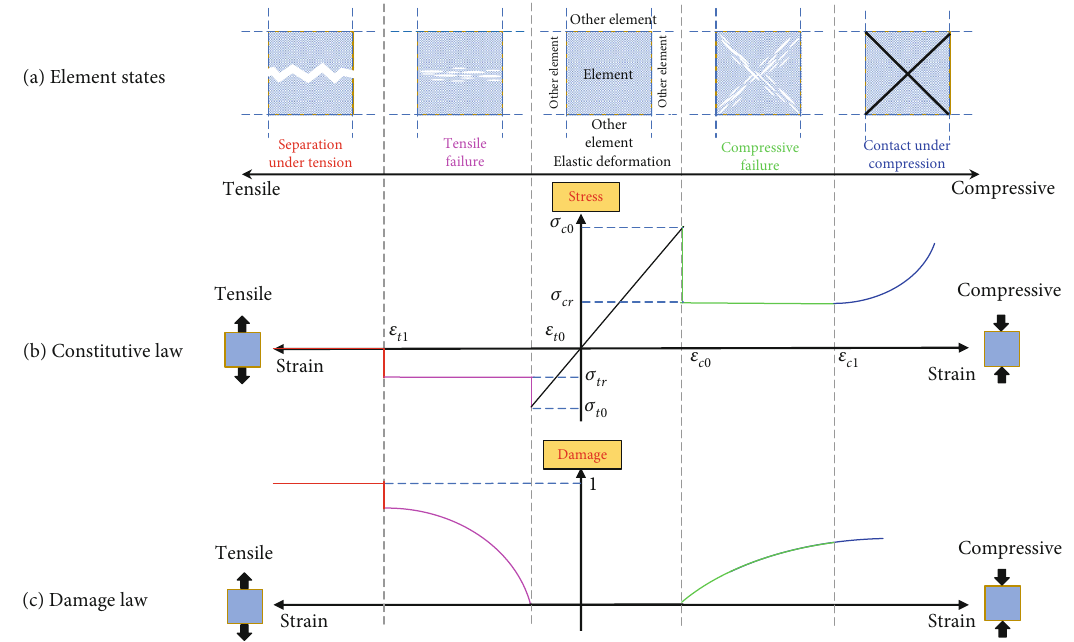
Figure 5: Elastic damage constitutive relation of the element under uniaxial